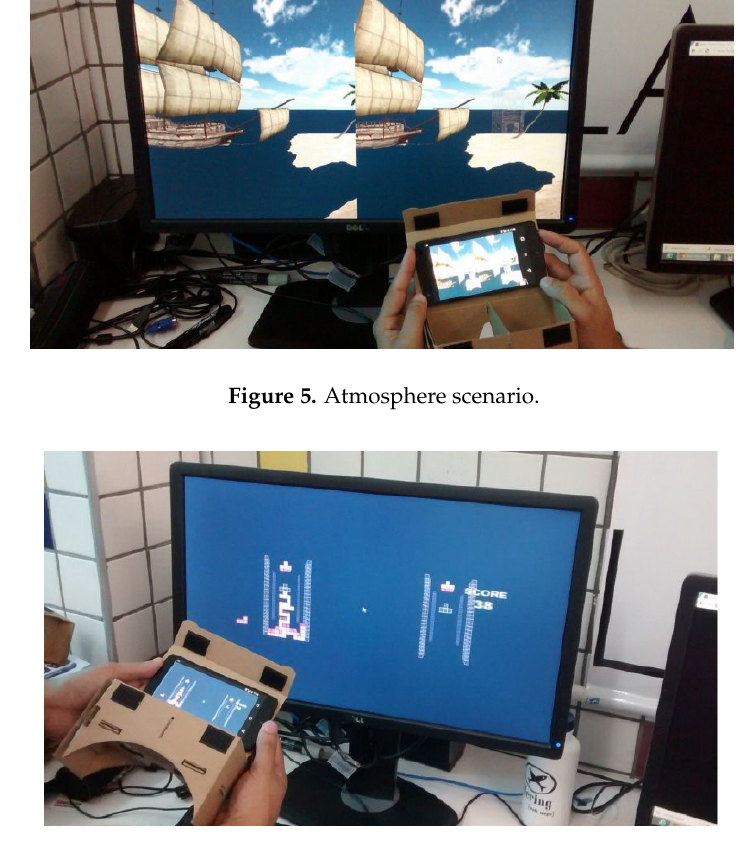
Figure 6. Activity scenario.